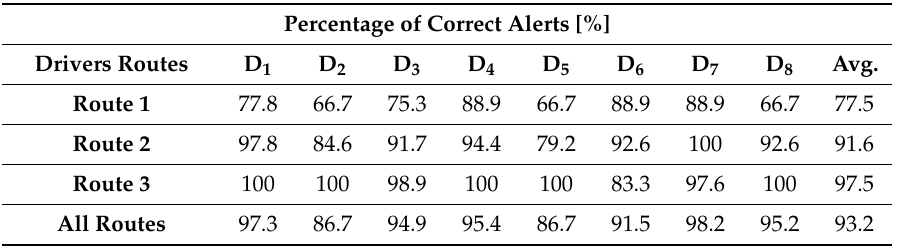
Table 3. Percentage of correct alerts for V 1 (Light Vehicle): Route 1, Route 2, Route 3 and all